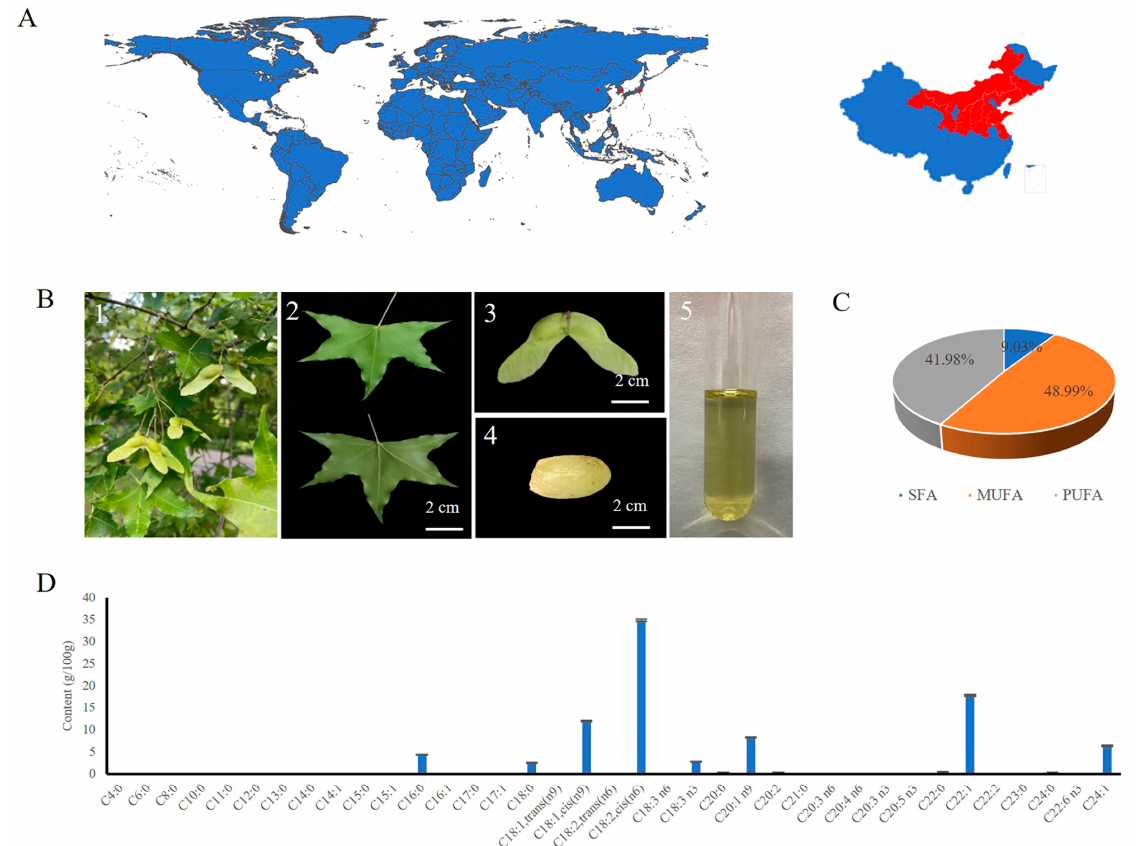
Figure 1. ( A ), Geographic distribution map of Acer truncatum in the world and China. ( B ), Acer truncatum ( B1 ), leaves ( B2 ), fruit ( B3 ), seed ( B4 ), and oil ( B5 ) of Acer truncatum . ( C ), Percentage of di ff erent types of fa tt y acids in the Aoil. ( D ), Fa tt y acid composition of the Aoil.